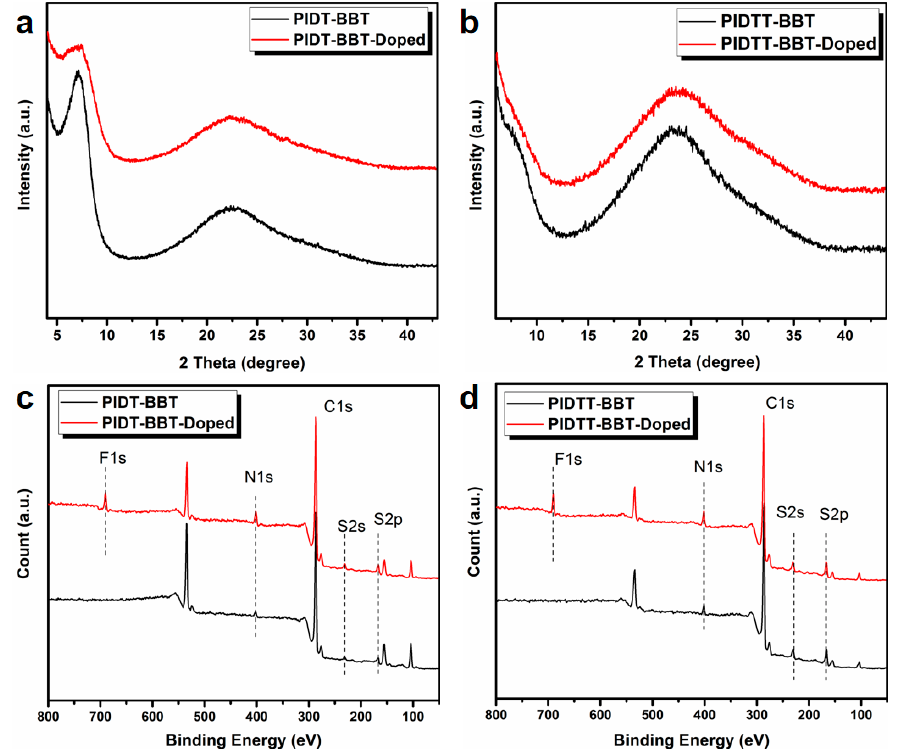
Figure 4. GI-XRD curves of pristine and doped ( a ) PIDT-BBT and ( b ) PIDTT-BBT films; XPS spectra of pristine and doped ( c ) PIDT-BBT and ( d ) PIDTT-BBT films. of pristine and doped ( c ) PIDT-BBT and ( d ) PIDTT-BBT